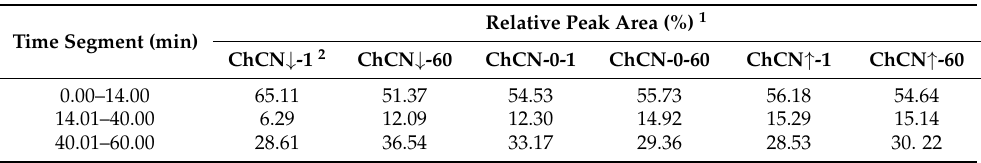
Table 5. Peak area percentages calculated for water-soluble extracts of Gouda cheese with the modified β -casein content separated using